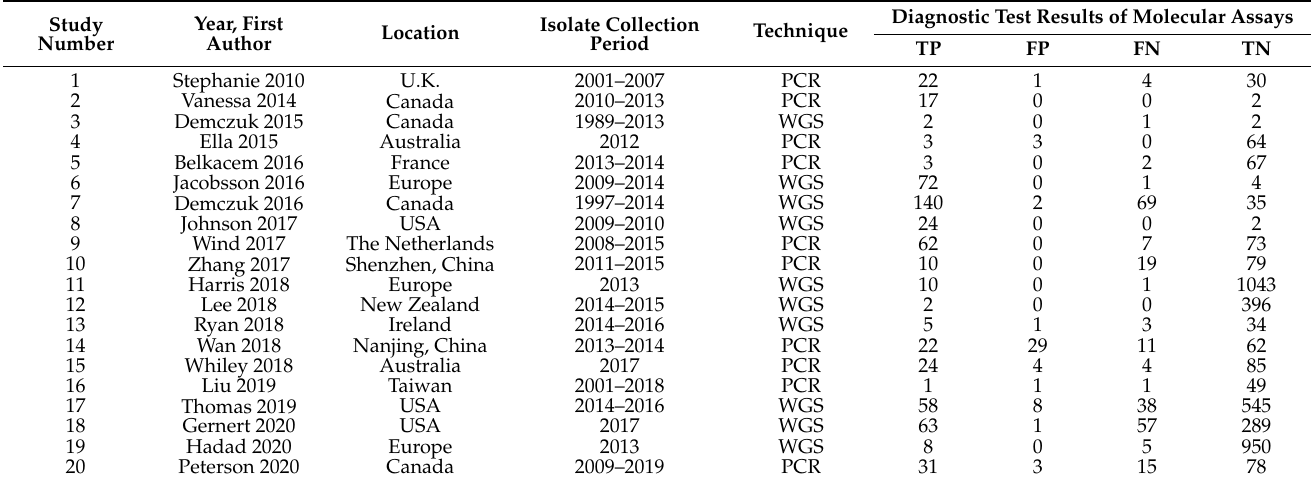
Table 2. The data and characteristics of 20 studies whose moderate-level drug resistance breakpoint was 2–128 mg/L. WGS, whole-genome sequencing.